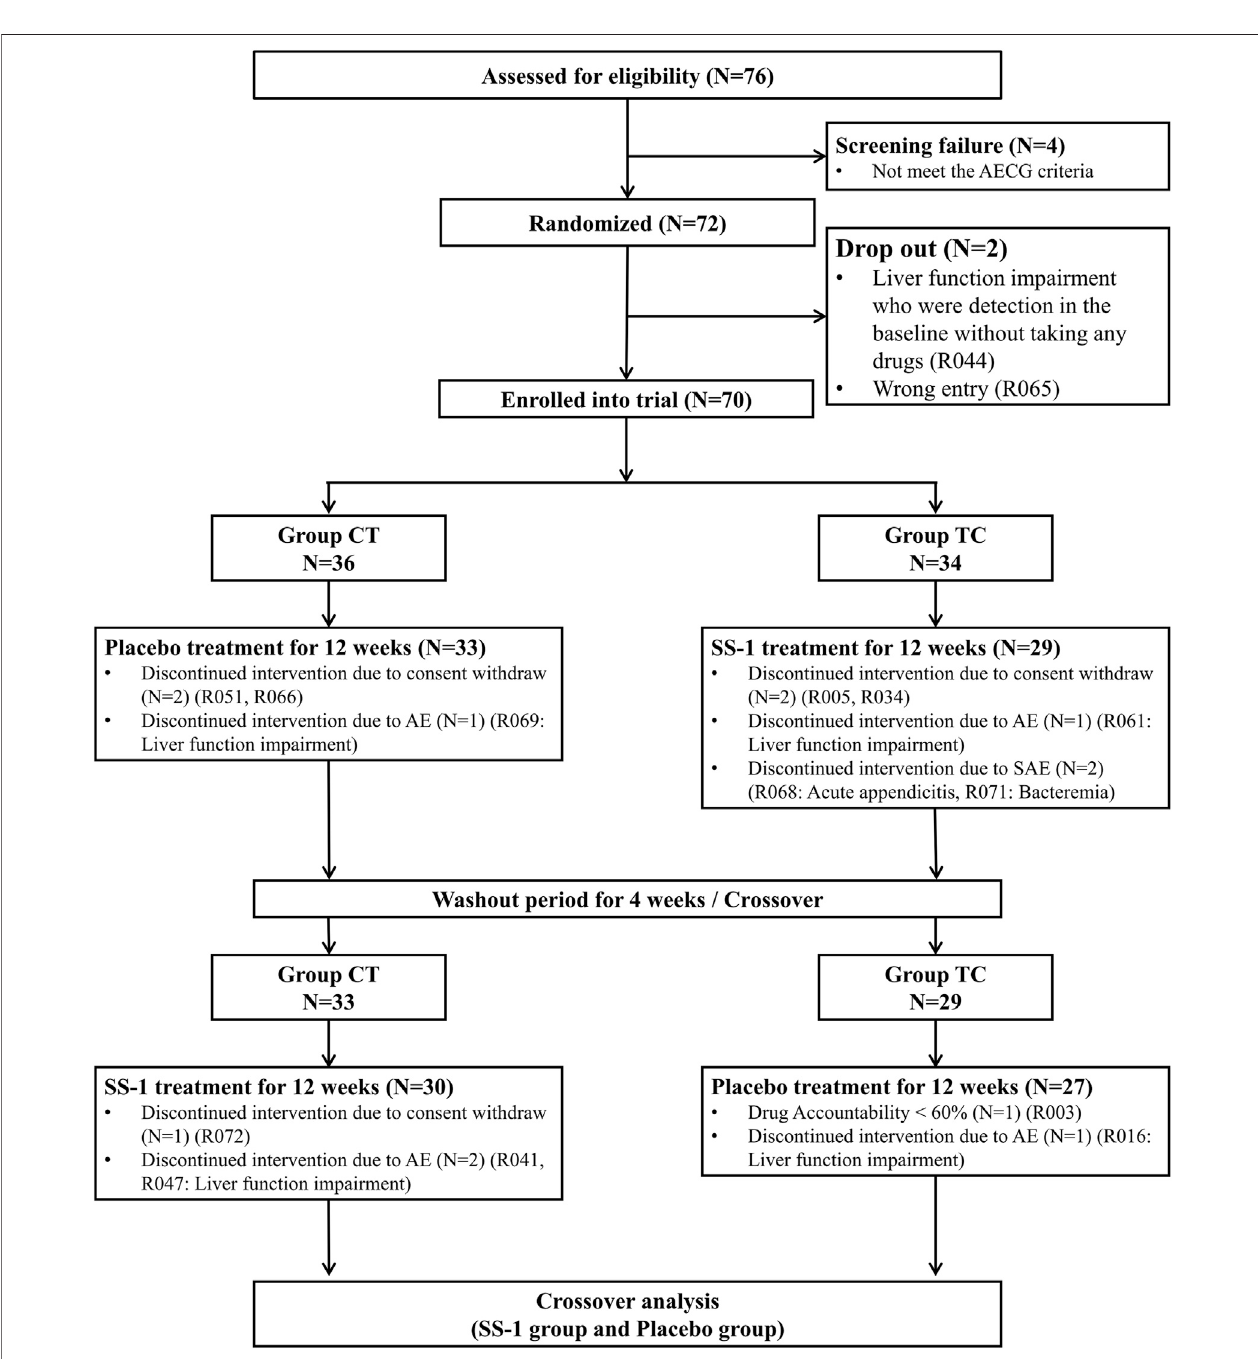
FIGURE 3 | Flowchart of recruitment of patients with Sjögren ’ s syndrome in this integrated clinical trial.